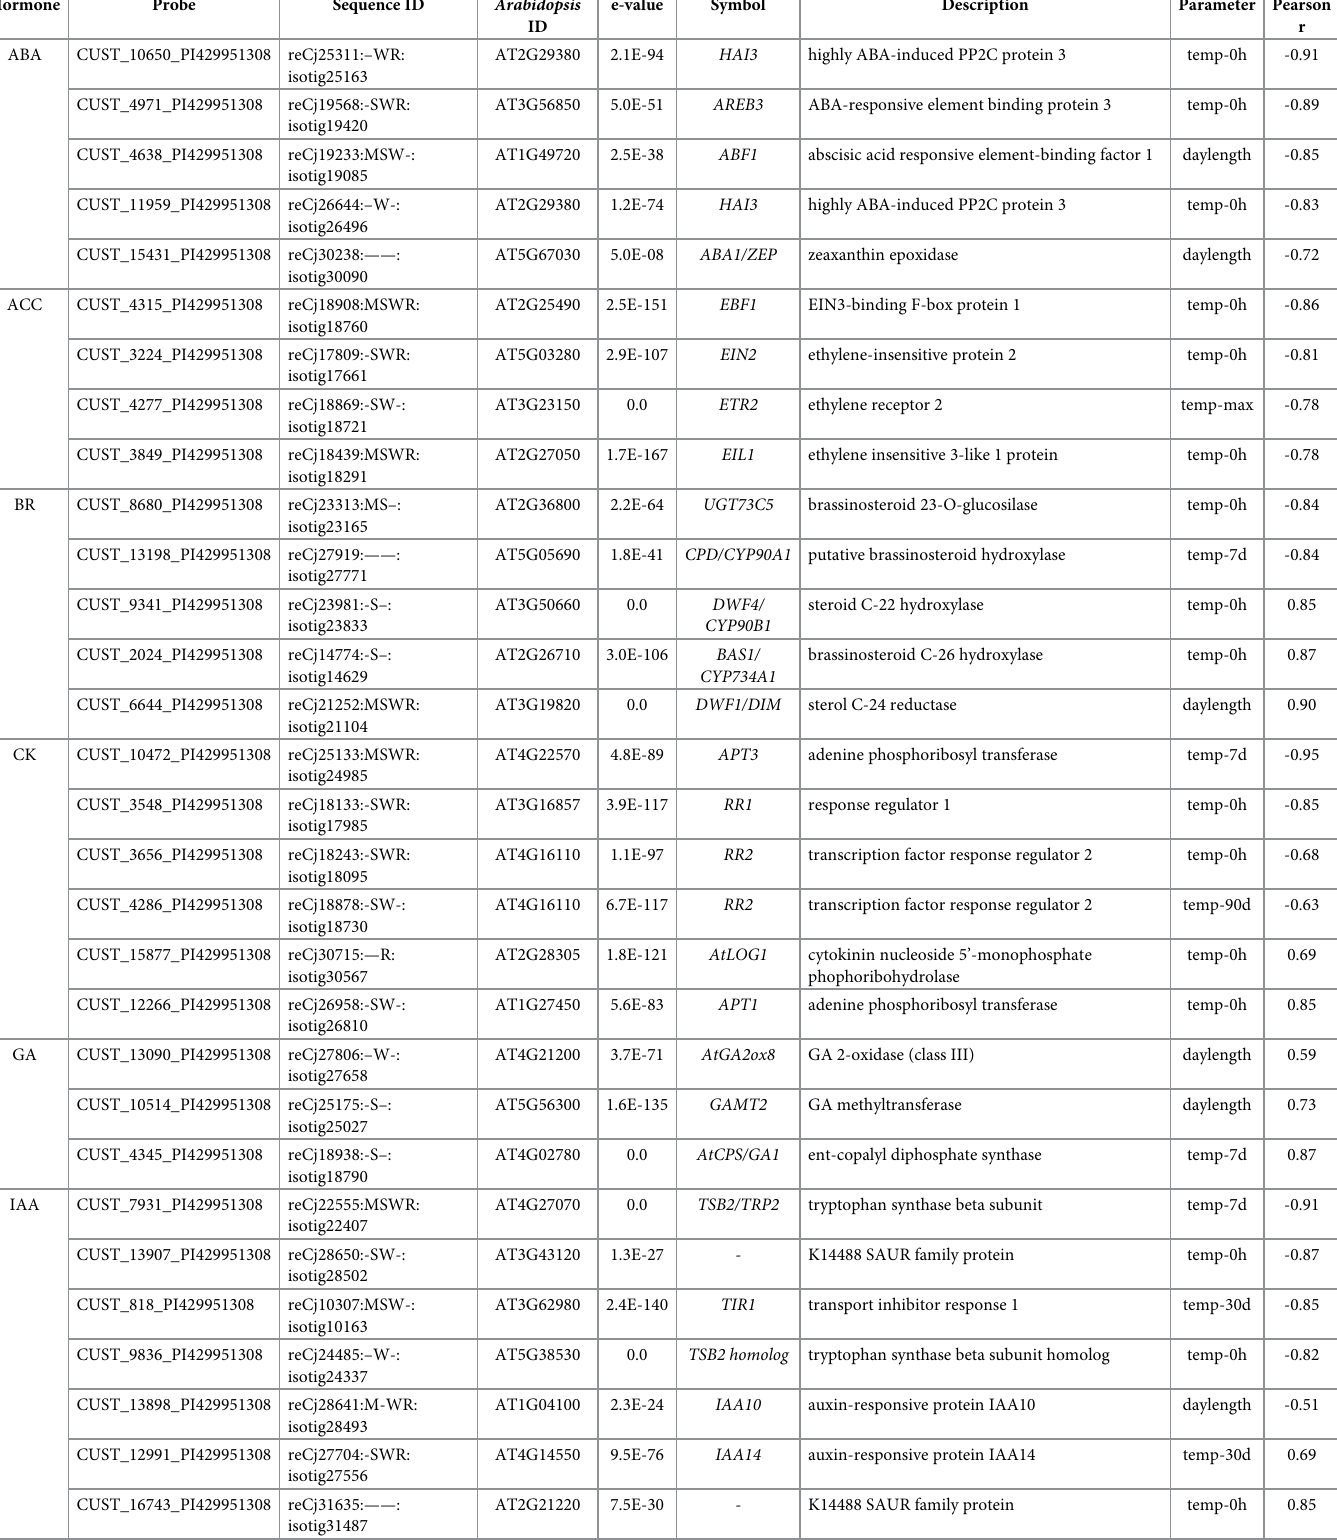
Table 6. Hormone-related genes that exhibited differential expression patterns among the three sites.